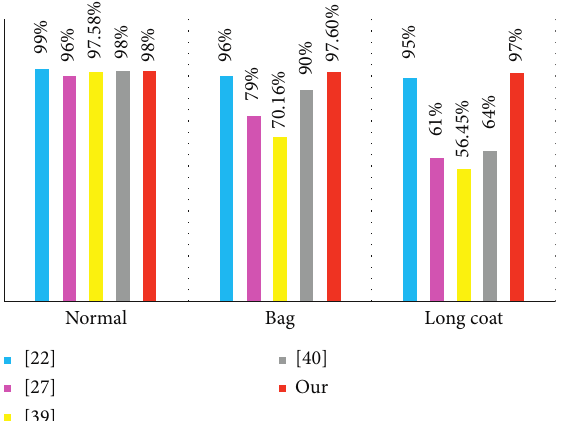
Figure 20: Comparison of our work with [22, 27, 39,